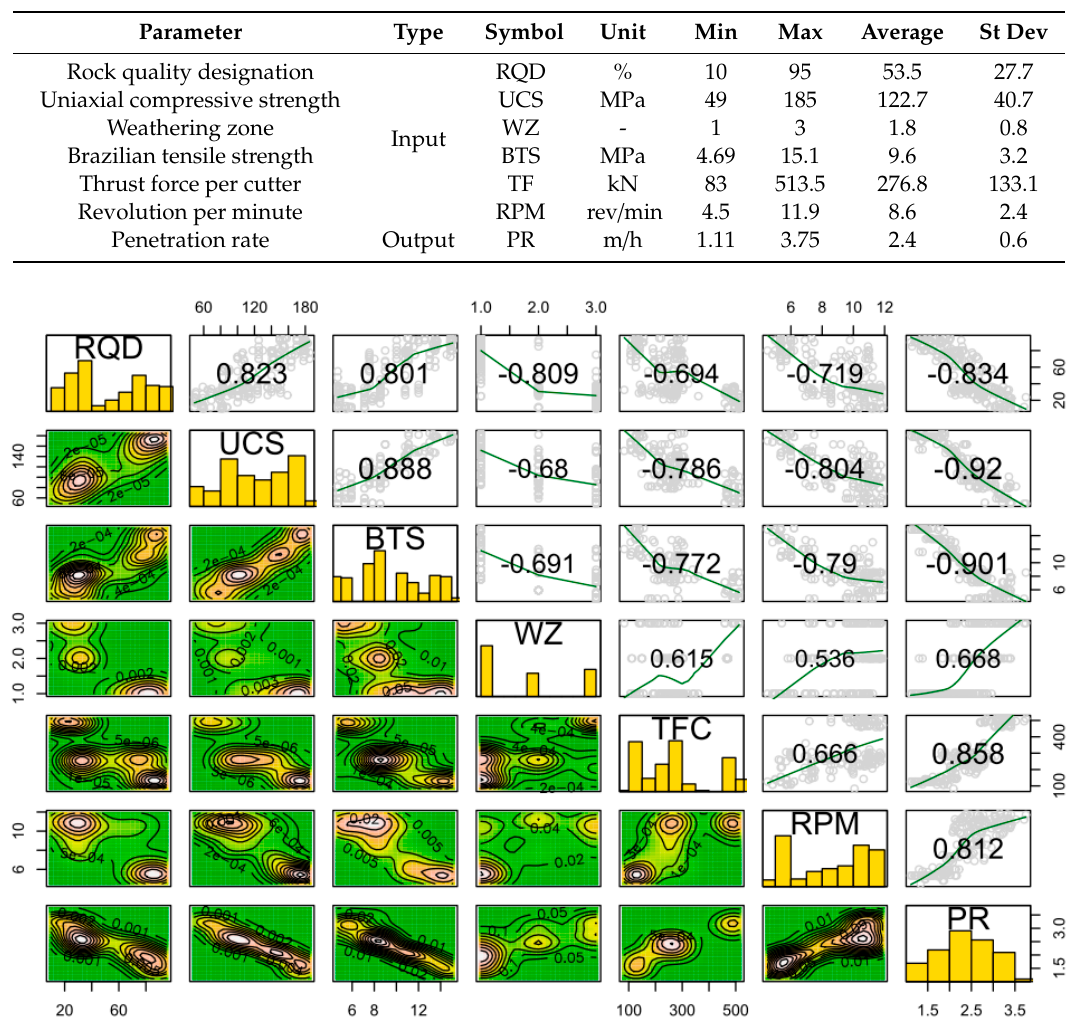
Figure 4. Correlation matrix of input and output variables for 209 cases.